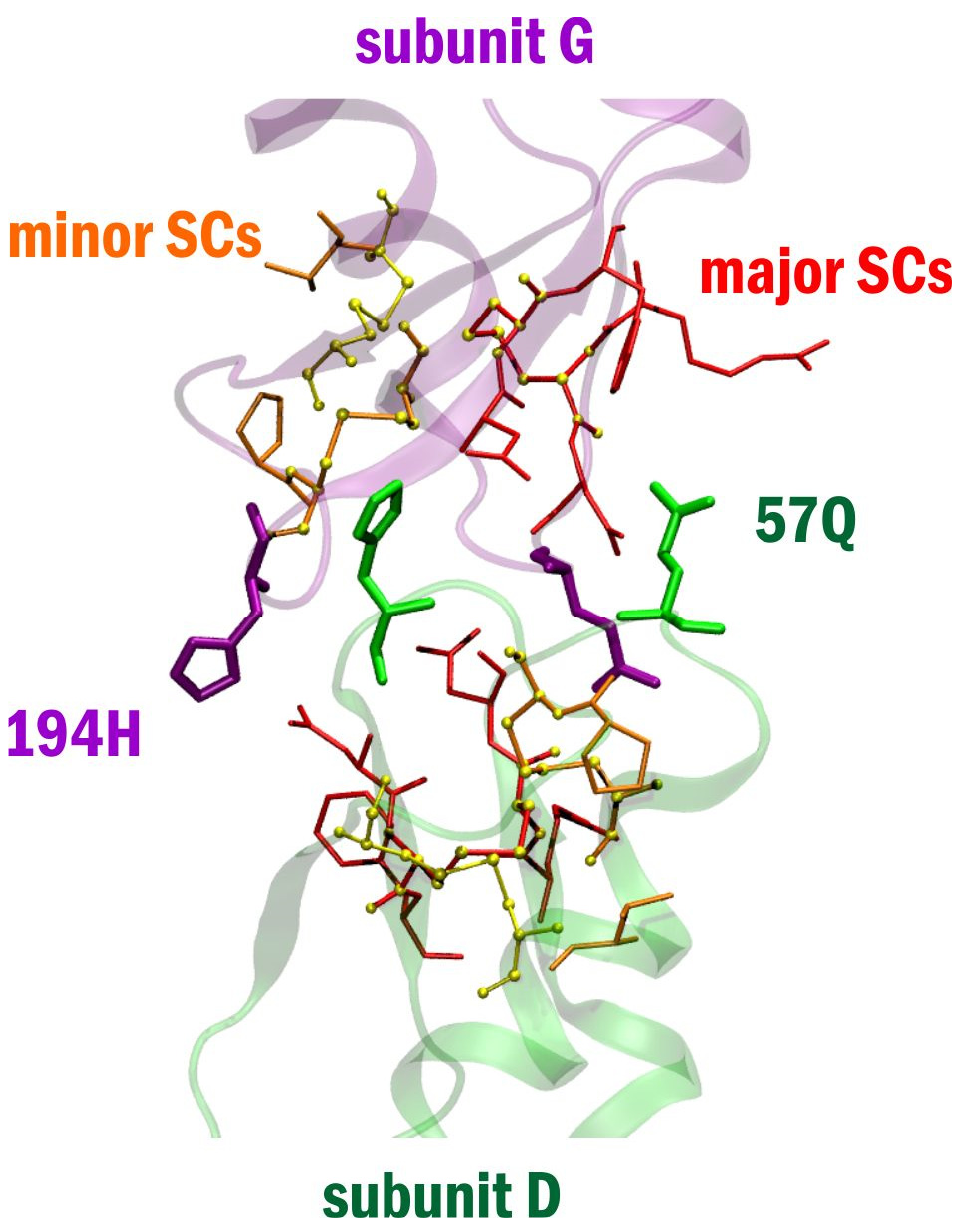
Figure 3. Inter-loop stabilization centers in the Cx43 GJ interface domain. Colour code: green cartoon—subunit D; purple cartoon—subunit G; major stabilization centers (53R, 54 C , 55 N , 197 D , 198C, 199F) are shown in red thin stick, minor stabilization centers (61 C , 64V, 191 P , 192 C ) are shown in orange thin stick. Cystine disulfides are shown in thin yellow stick. Atoms of cystine disulfides are also marked by yellow ball to allow their visualization in case they are involved in stabilization centers as well. 57Q, 194H are shown in thick stick colored according to the subunit they belong to.